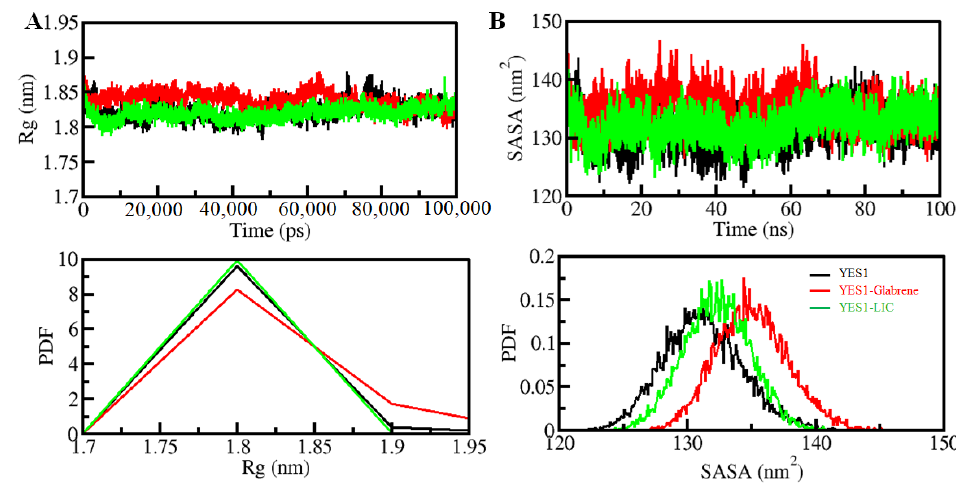
Figure 4. Structural compactness and folding of YES1 upon Glabrene and LIC binding. ( A ) R g plot and ( B ) SASA plot of YES1 with Glabrene and LIC. Lower panels show the probability distribution function values as